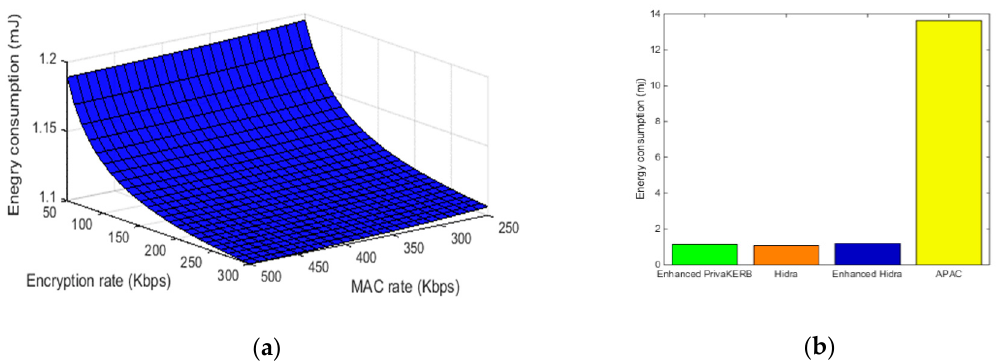
Figure 10. Energy consumption results: ( a ) impact of the MAC computation rate and the encryption rate on the energy consumption of sensor nodes; ( b ) energy consumption comparison of sensor nodes among enhanced Hidra, enhanced PrivaKERB and Hidra.